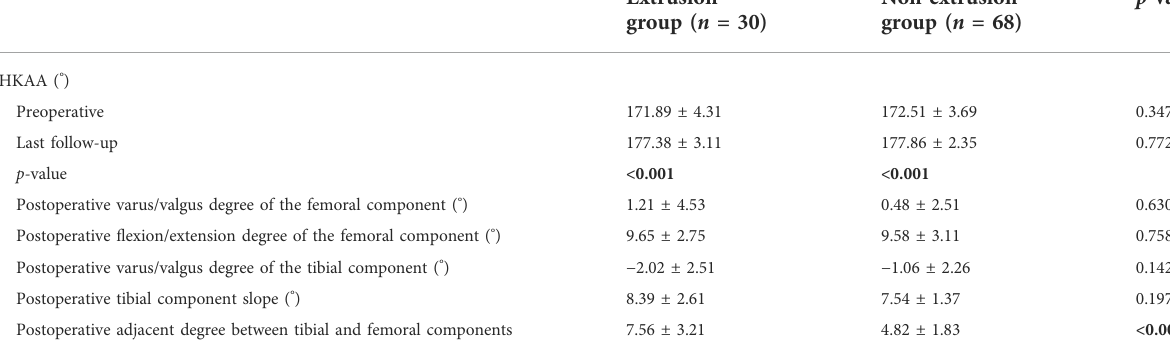
TABLE 4 Comparison of the radiological measures between the two